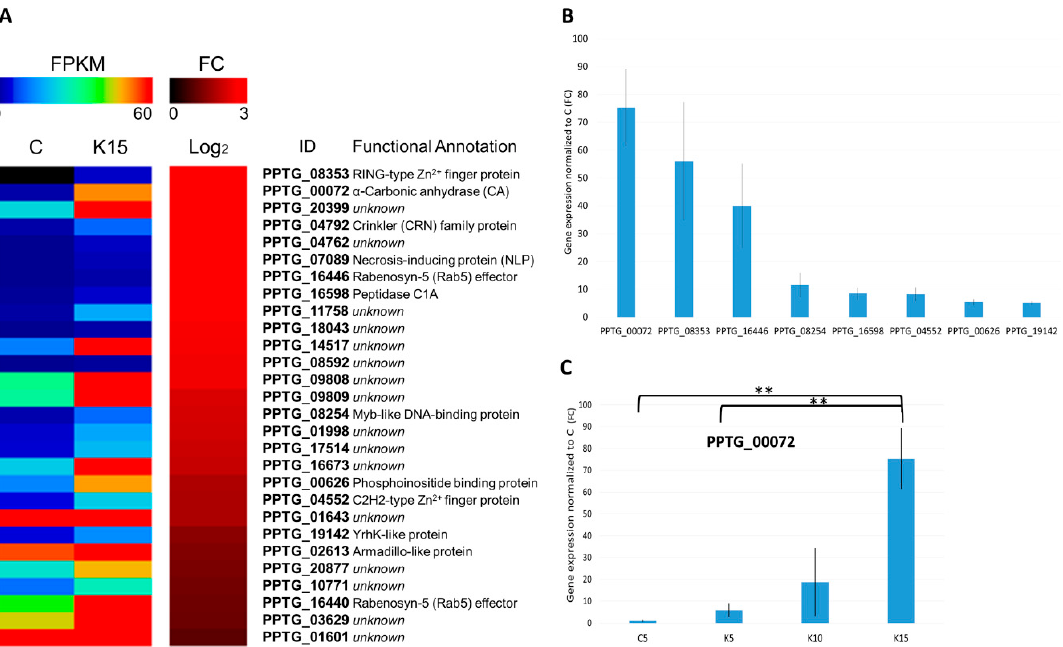
Figure 3. Overview of upregulated genes. ( A ) Heat map of expression levels (Fragment Per Kilo base of exon per Million reads, FPKM; left part of the panel) and fold change (FC, log2; right part of the panel) of significantly upregulated genes (defined by their ID and putative functional annotation) upon K + application (K15 sample) compared to freely swimming zoospores (C sample). Only genes with FC > 2 (log2 > 0) were considered. Correspondence between colors and FPKM or FC is reported in the scale at the top of each panel; ( B ) expression of a selection of upregulated genes, analyzed by RT-qPCR and expressed as FC in K15 sample compared to C. Panels C shows the differential expression of Carbonic Anhydrase (CA) PPTG_00072, expressed as FC, at different times after K + application (K5, K10, K15), compared to the C sample, analyzed by RT-qPCR. ** p < 0.01.